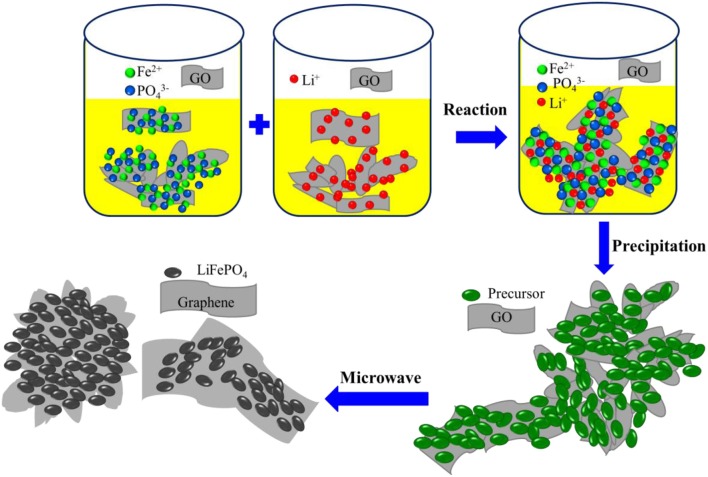
Schematic illustration of the formation process of LiFePO4/graphene composites.